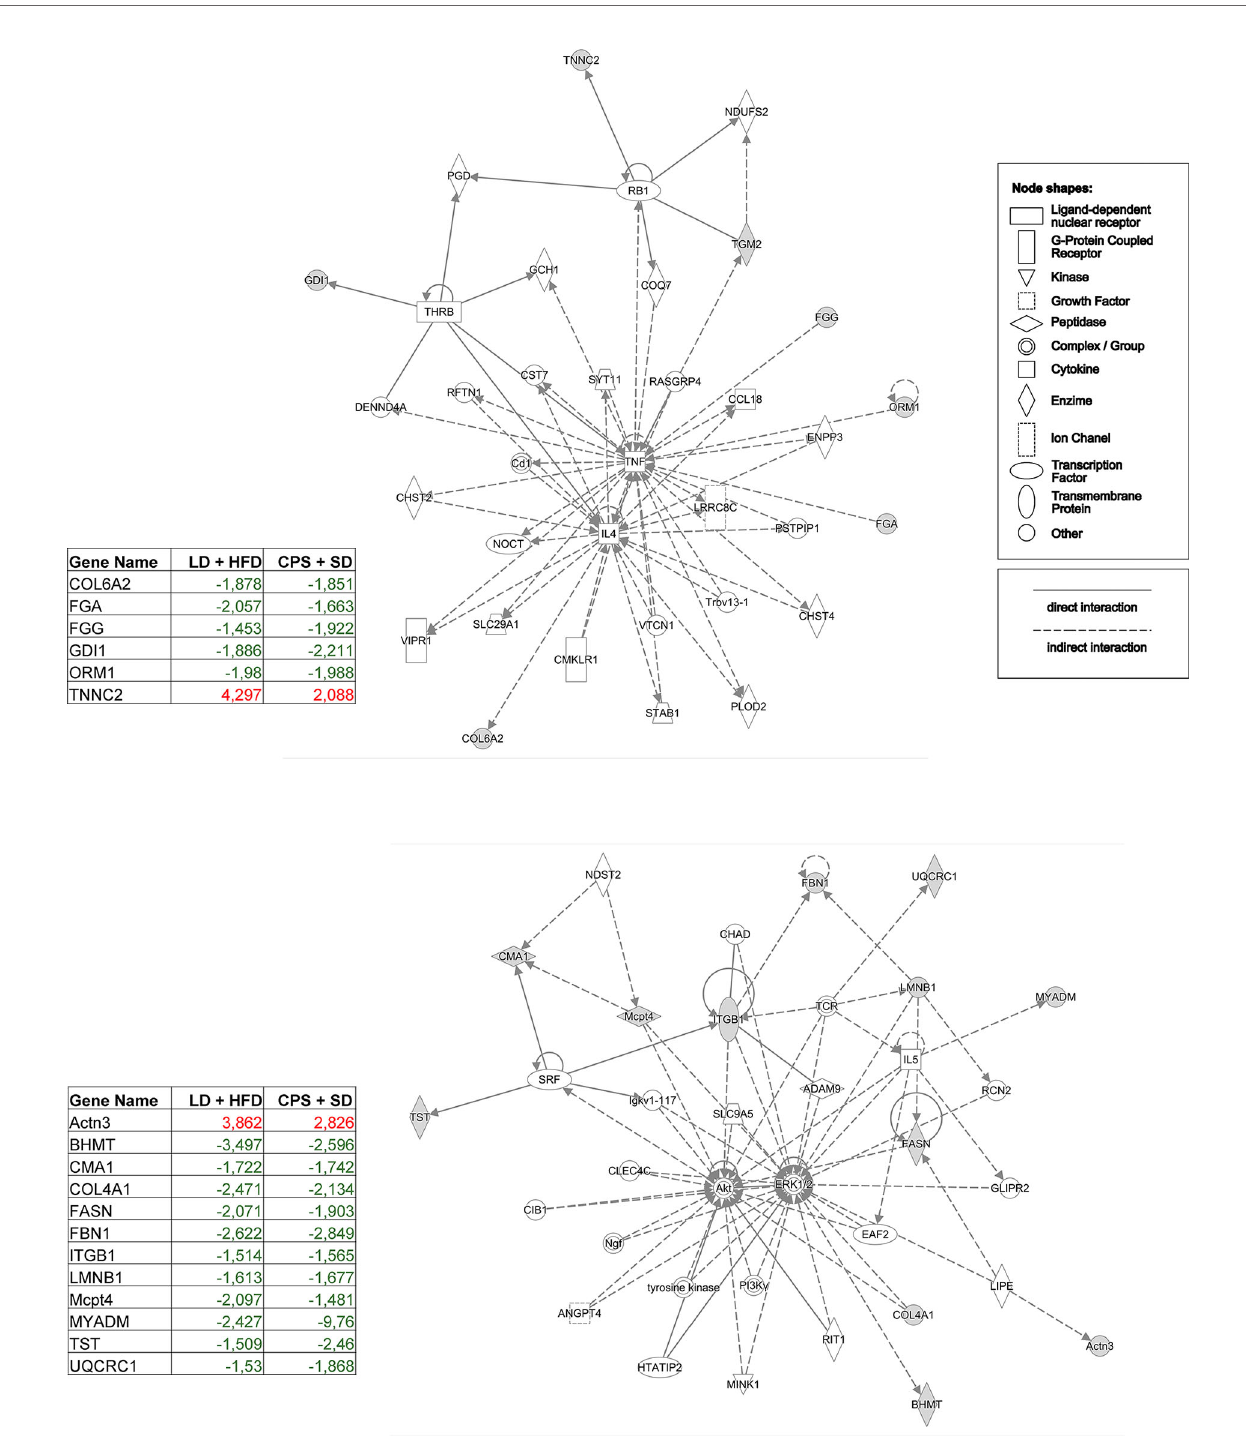
FIGURE 10 | Interactome depicting the pathways that were most signi fi cantly enriched by differentially expressed proteins identi fi ed by quantitative proteomics of white adipose tissue (WAT) from adult offspring. Comparison: adult offspring that had been gestated under control (LD) conditions and fed with high-fat diet (HFD) during 12 weeks from postnatal day 100 onwards (LD + HFD group) versus adult offspring that had been gestated under CPS conditions and fed with standard diet postnatally (CPS + SD). Red, upregulated protein; green, downregulated protein; white, protein related in the network without expression changes. Proteins connected with solid lines have direct links; those connected with dotted lines have indirect links. The set of proteins was grouped in the Ingenuity Top Network 1: Cellular Development, Cell Morphology, Cell-Mediated Immune Response, and In fl ammatory Response